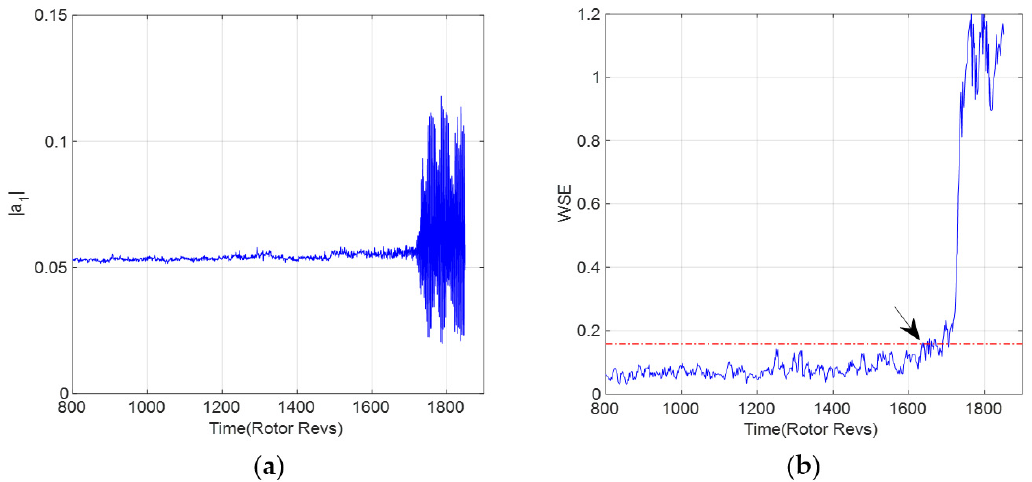
Figure 7. Wavelet singular spectral entropy of the spatial mode at 3000 rpm: ( a ) First-order space mode; ( b ) Wavelet singular spectral